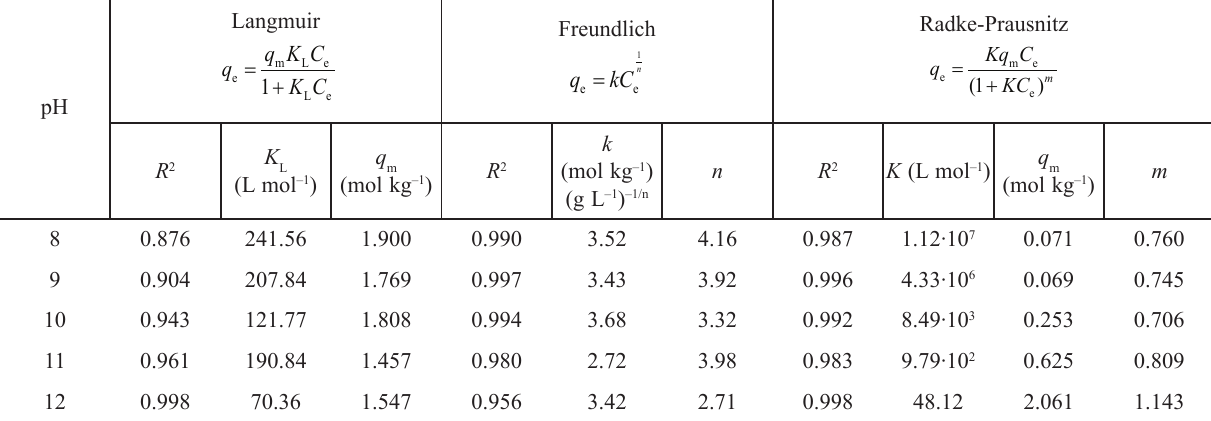
Table 2 – Langmuir, Freundlich and Radke-Prausnitz isotherm parameters for D-GA adsorption on the resin 201×7